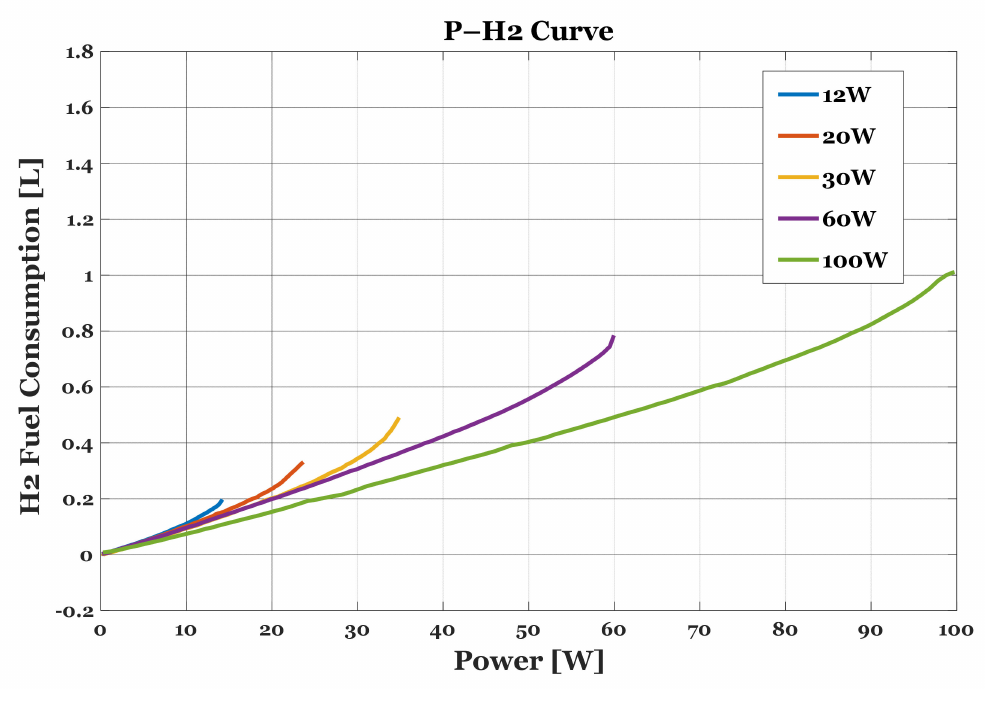
Figure 9. Experimental results for H 2 -P.